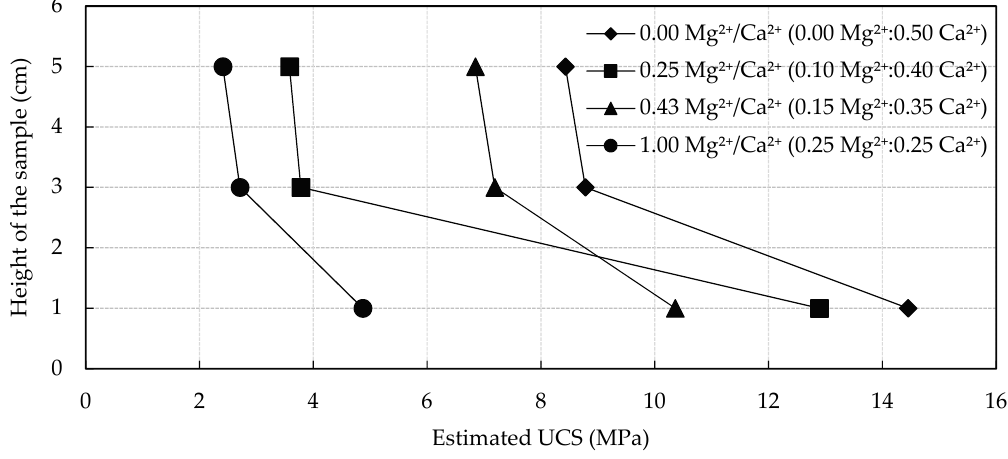
Figure 13. Variation of local strength of MICP treated sand for different Mg 2+ /Ca 2+ molar ratios.